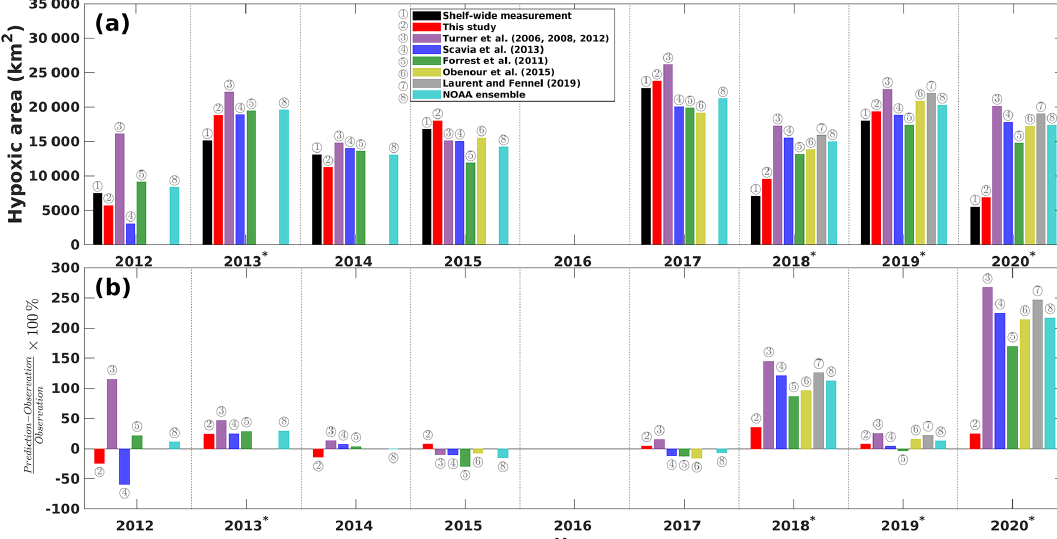
Figure 8. (a) Comparisons of shelf-wide measured and the best estimates of model-predicted HA during the shelf-wide cruise periods. (b) Percentage differences between different model predictions and shelf-wide measurements. The superscript asterisks indicate high-wind years prior to the